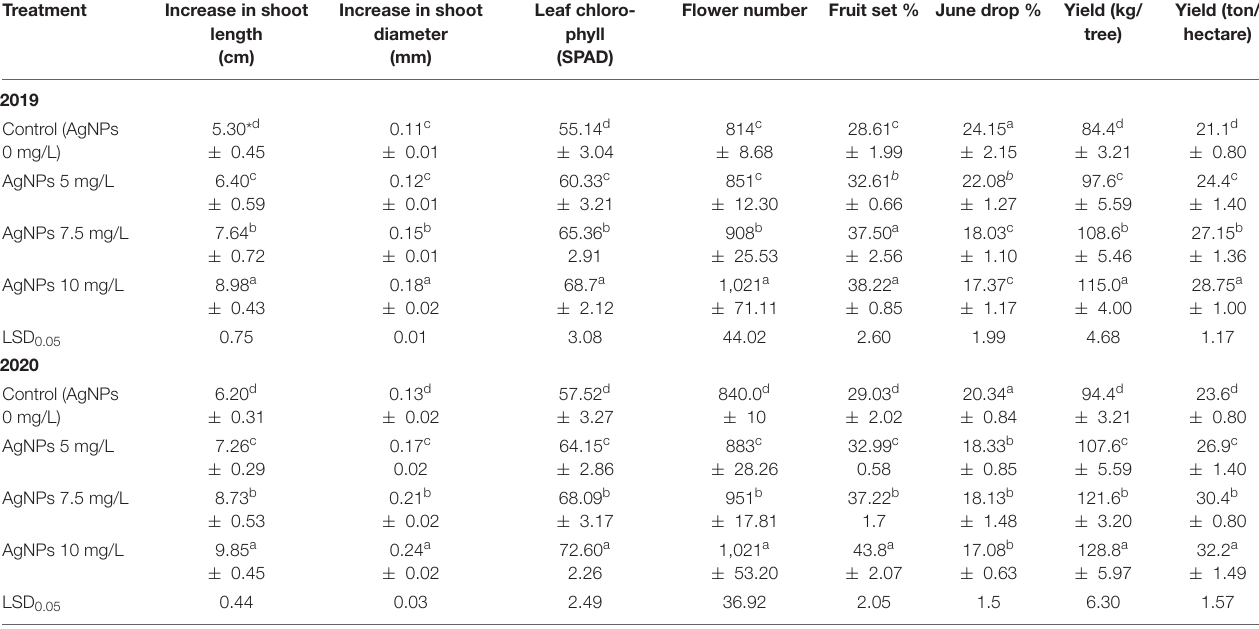
TABLE 2 | Influence of AgNPs spraying on shoot length, shoot diameter, leaf chlorophyll, flower number, fruit set %, June drop %, and yield of “Eureka” lemon during 2019 and 2020 seasons. Treatment Increase in shoot length